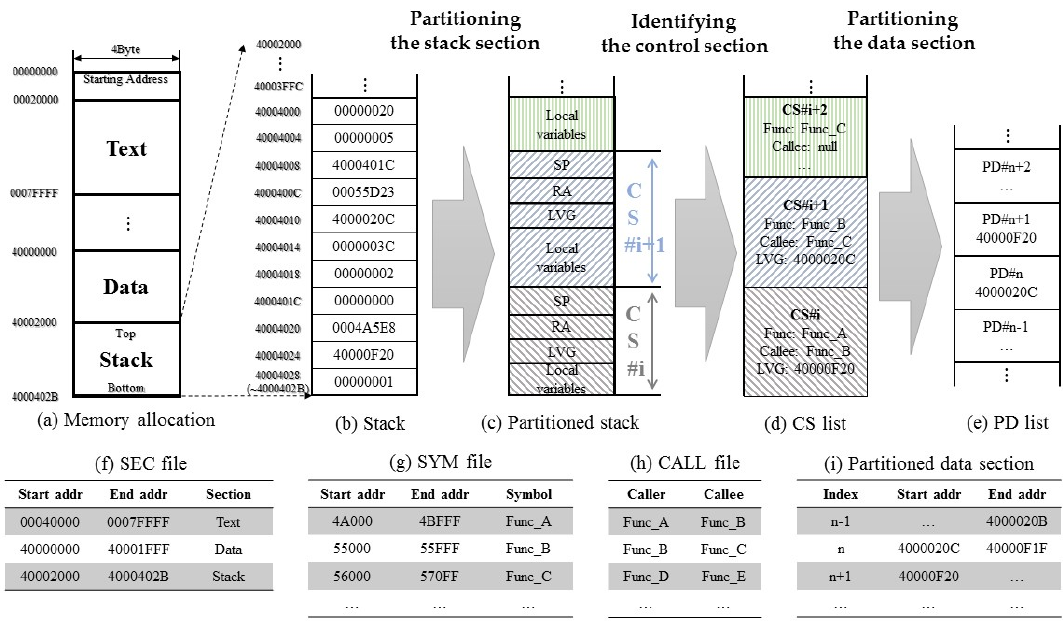
Figure 9. Example of partitioning the data section using the stack ( a – i ).